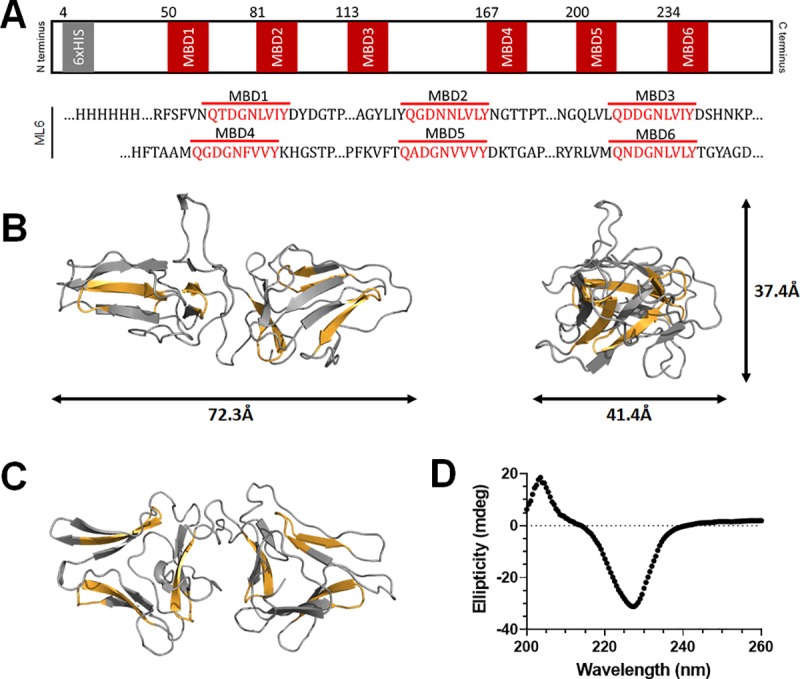
Sequence and structure of recombinant ML6.(A) Schematic representation of the ML6 sequence (top) with unique instances of mannose-binding domains identified (bottom, red). (B) Predicted computational structure of ML6 using the SWISS model (bacteriocin LlpA reference) viewed from the front (left) and side (right). (C) Top-down view of ML6 emphasizing the central “C” cup. Mannose-binding domains are highlighted yellow. (D) Circular dichroism spectrum of recombinant ML6 protein.